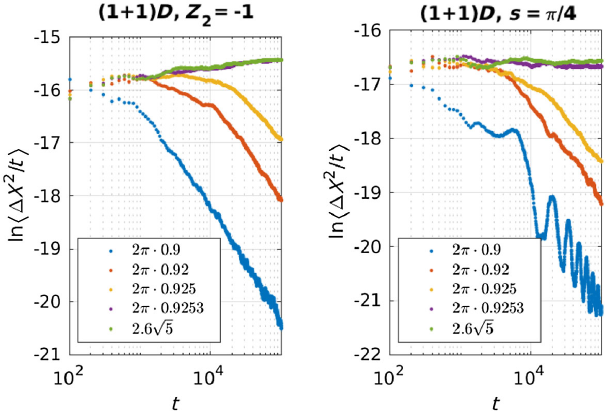
FIG. 6. Wave-packet spread for quantum simulators of finite- size class-AII topological metals FM 1 (left panel) and 2 D þ 1 syn class-A critical metals (right panel). The size of the compact dimension increases with the number of decimals kept in the rational approximation α , and the dimensional crossover in the dynamics is observed at increasingly later times (see also discussion in main